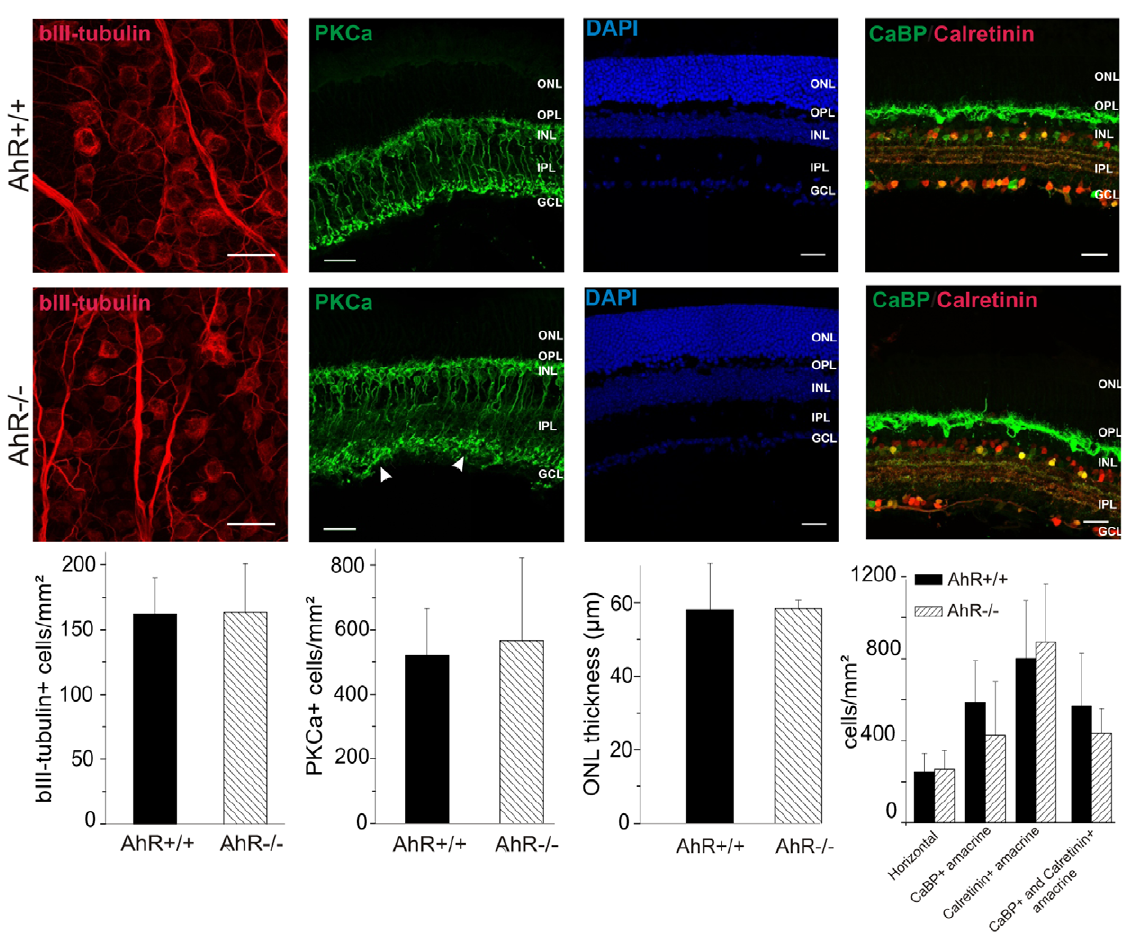
Figure 6. AhR 2 / 2 mice retinal cells are functional despite scattered bipolar to RCG connections. Immunohistochemistry experiments were performed in retina sections of adult AhR + / + and AhR 2 / 2 mice. AhR + / + and AhR 2 / 2 retina at P56 is represented. Retinal ganglion cells (RGC) are labeled with antibodies against ßIII-tubulin; bipolar cells are labeled with antibodies against PKC a (Protein Kinase C a ), nucleus is labeled with DAPI; amacrine and displaced amacrine cells are labeled with both antibodies against calbindin (CaBP)-D28k and calretinin. Horizontal cells are stained with antibodies against calbindin. The density of RGC, bipolar, amacrine and displaced amacrine, and horizontal cells are not significant different between AhR + / + and AhR 2 / 2 mice (see quantifications at the bottom of the figure). The thickness of the ONL is the same between both genotypes. The white arrows in the bottom panel of the PKCa staining indicate a disorganization of the synapses between the bipolar cells and the RGCs in some AhR 2 / 2 mice. Scale bar =25 m m. ONL: Outer Nuclear Layer, INL: Inner Nuclear Layer, GCL: Ganglion Cells Layer, OPL: Outer Plexiform Layer, IPL: Inner Plexiform Layer.